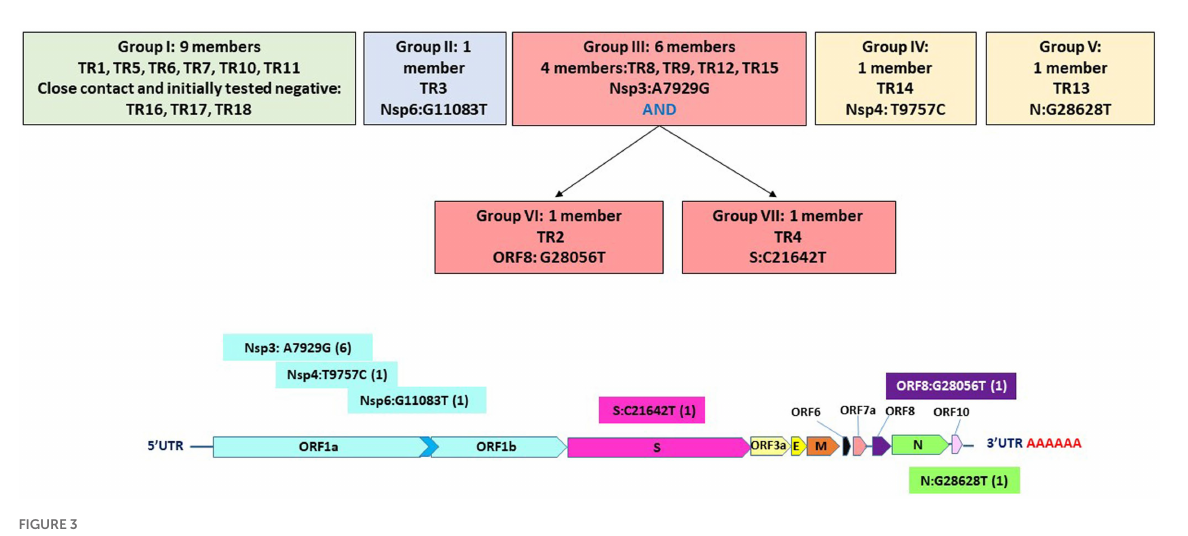
FIGURE 3 Seven groupings based on six high-quality single-nucleotide variations and their positions on the genome.